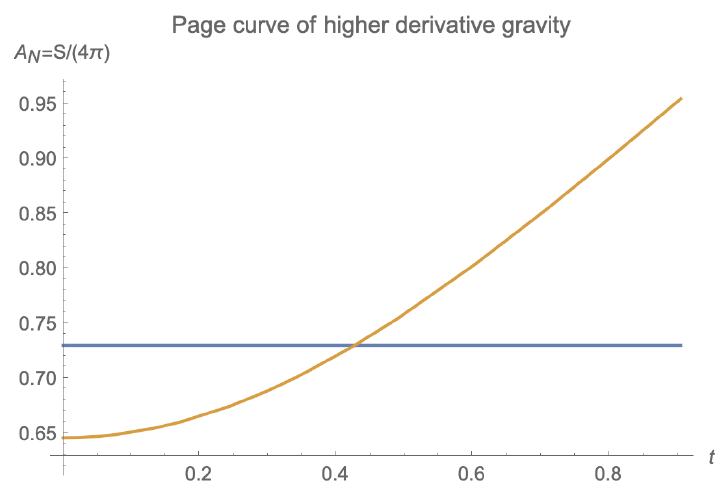
Figure 17 . Page curve of case I with higher derivative gravity on the branes. We have set d = 4 and V = 1 . The orange and blue lines denote the RT surface in the no-island and island phases. The Page curve is given by the orange line before Page time, and is given by the blue after Page time. The entanglement entropy firstly increases with time (orange line) and then becomes a constant (blue line), which recovers the Page curve of the eternal black